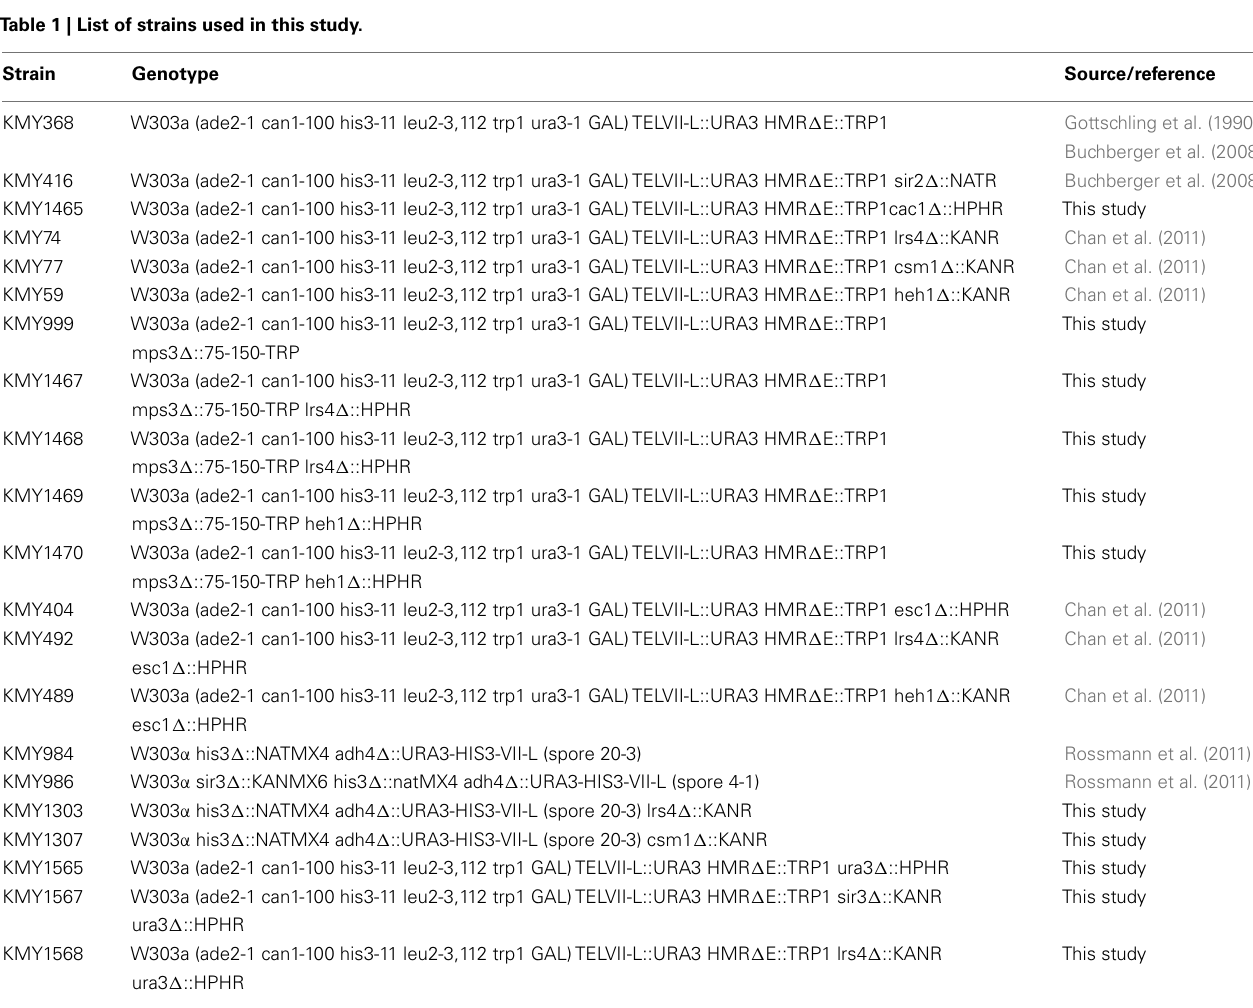
Table 1 | List of strains used in this